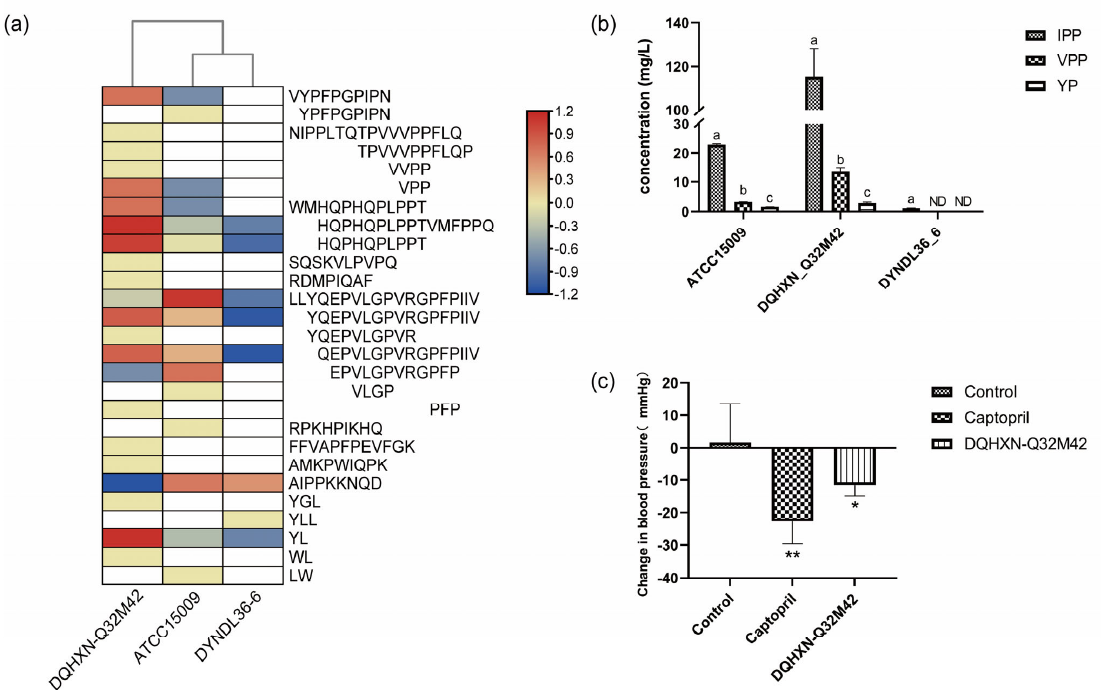
Figure 5. Distribution of ACE inhibitory peptides in Lactobacillus helveticus -fermented milk and their blood pressure regulation ability. ( a ) ACE-I peptides identified in fermented milk samples of L. helveticus . ( b ) Concentrations of IPP, VPP, and YP in the milks fermented by L. helveticus . Significant differences (One-way ANOVA with Tukey’s multiple comparison, p < 0.05) between groups are indicated with different letters (a, b and c) above the bars. ND means not detected. ( c ) Effects of single gavage of milks fermented by L. helveticus for blood pressure in early SHR. One-way ANOVA with Tukey’s multiple comparison; * p <0.05, ** p